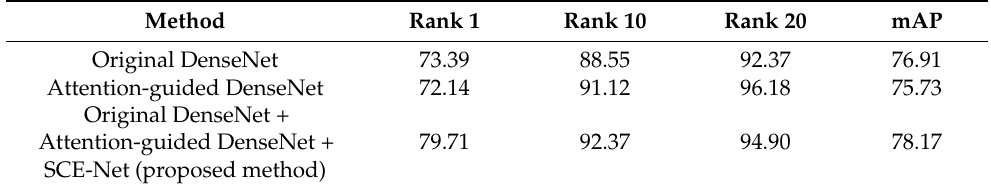
Table 4. Comparisons of ReID accuracies of the original DenseNet, attention-guided DenseNet, and proposed OADE-Net with DBPerson-Recog-DB1 (unit: %).